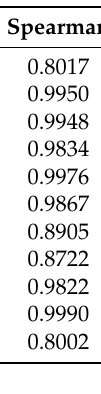
Figure 5. Relationship between genetic and physical positions with each chromosome. In each plot, genetic distance is on the x-axis, and physical distance is on the y-axis. Table 2. The Spearman correlation coefficients between the genetic and physical positions of each linkage group (LG).